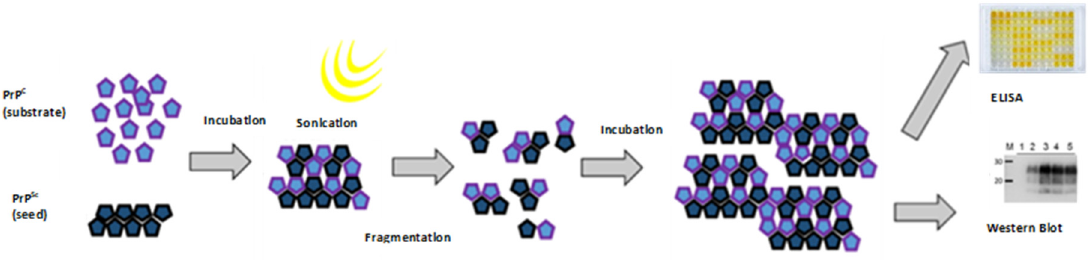
Figure 7. Principle of protein misfolding cyclic amplification (PMCA). Adapted from Ref.